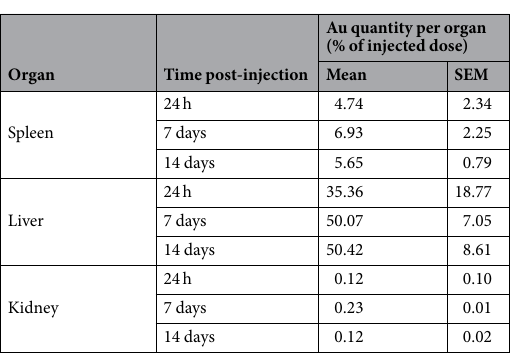
Au quantity per organ (% of injected dose)